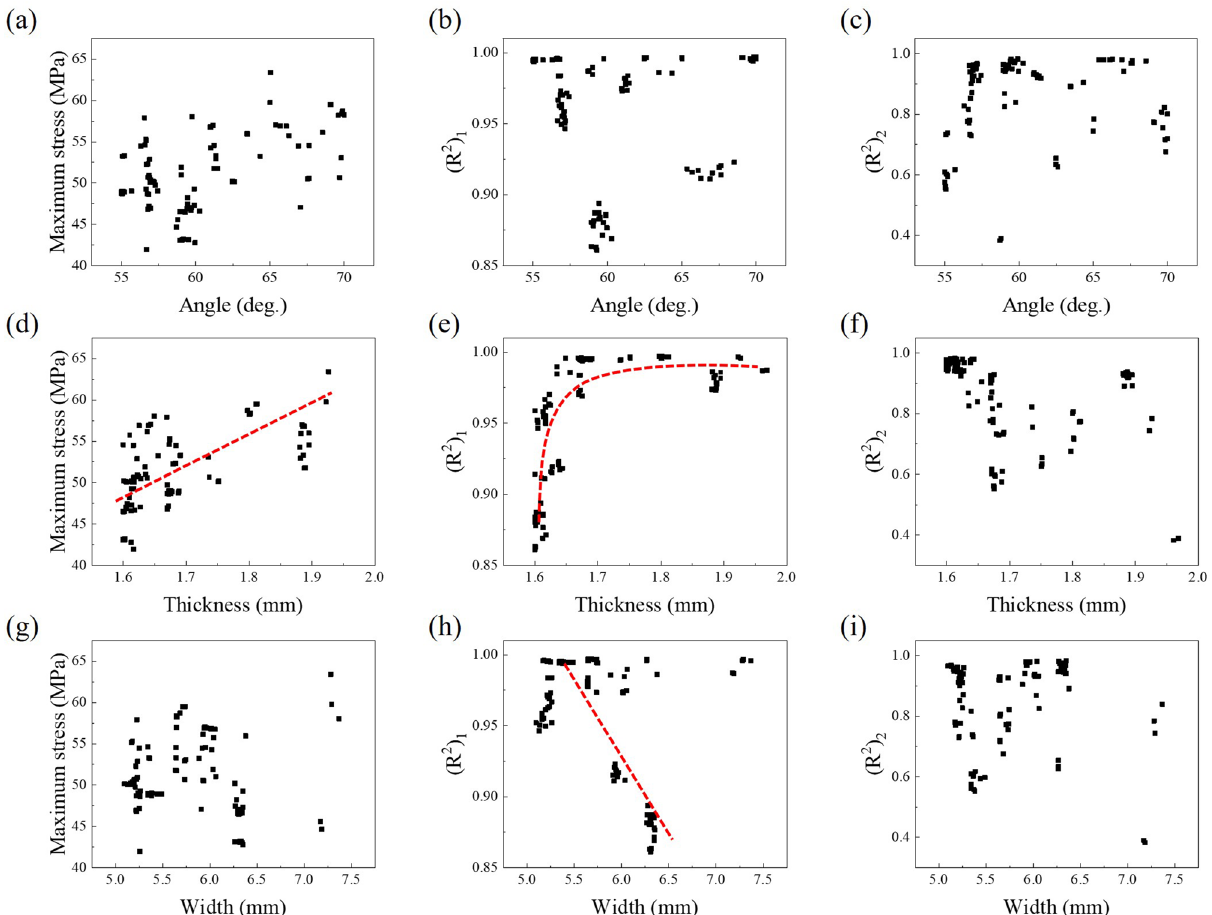
2 ) 2 ) 1 and ( R 2 ) results according to design variables of